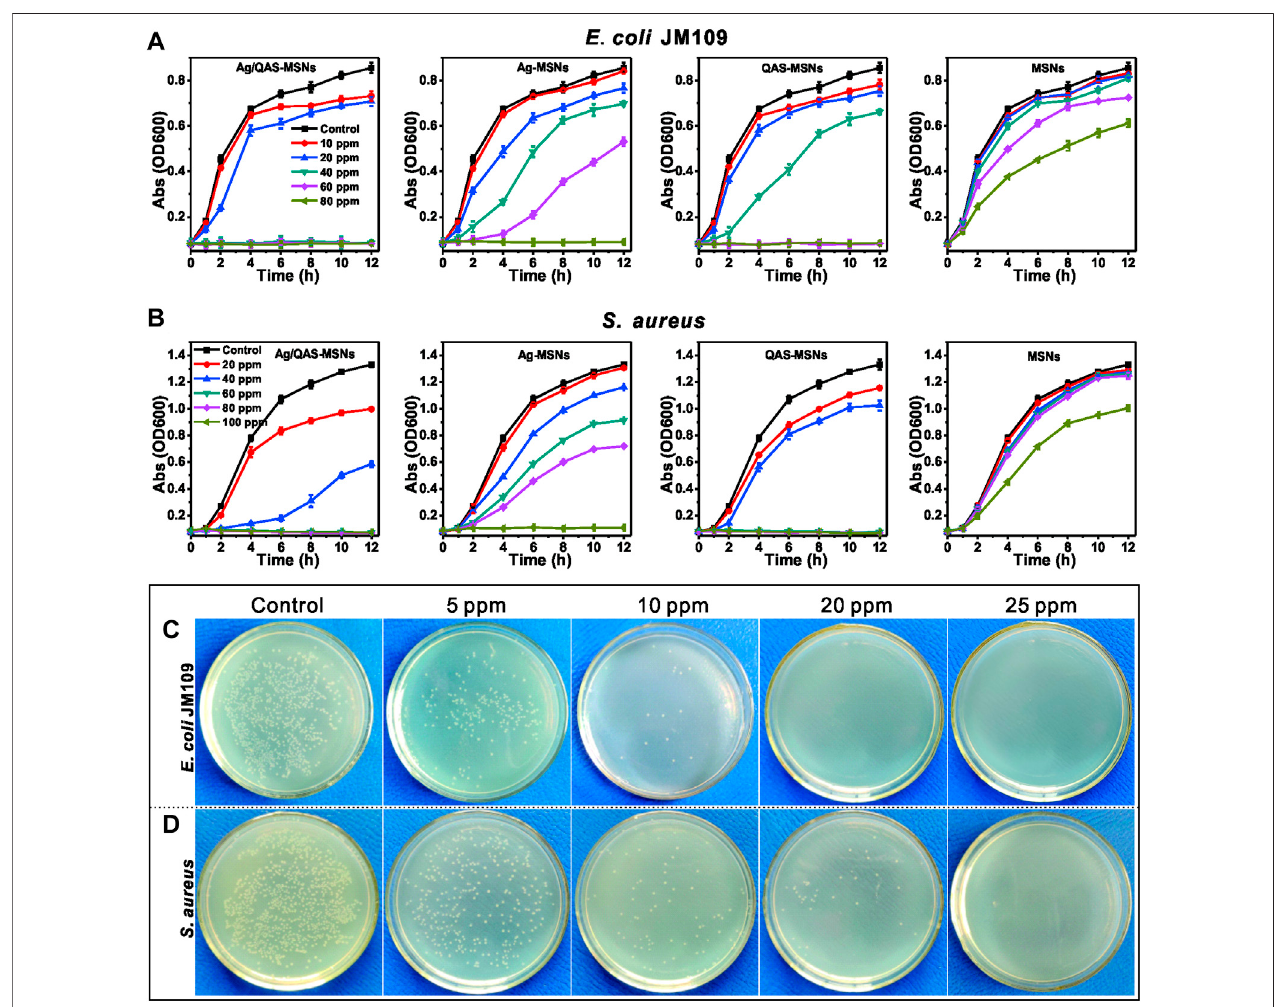
FIGURE6| Growthcurvesof E.coli (A) and S.aureus (B) inLBliquidmediuminthepresenceofdifferentconcentrationsofMSNs,Ag-MSNs,QAS-MSNs,andAg/ QAS-MSNs. E. coli (C) and S. aureus (D) grown on agar plates at different concentrations of Ag/QAS-MSNs.